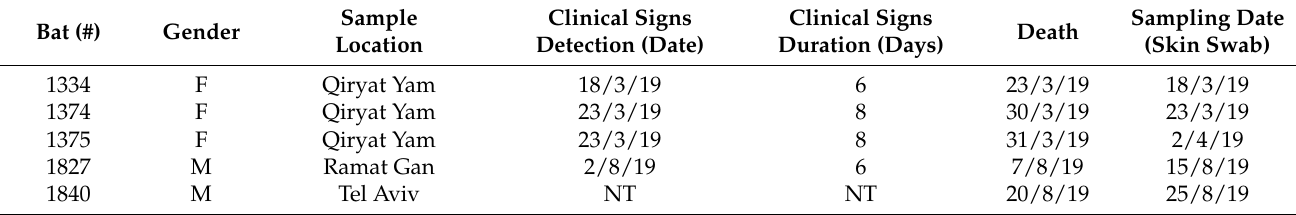
Table 1. Description and characteristics of Bats used in this